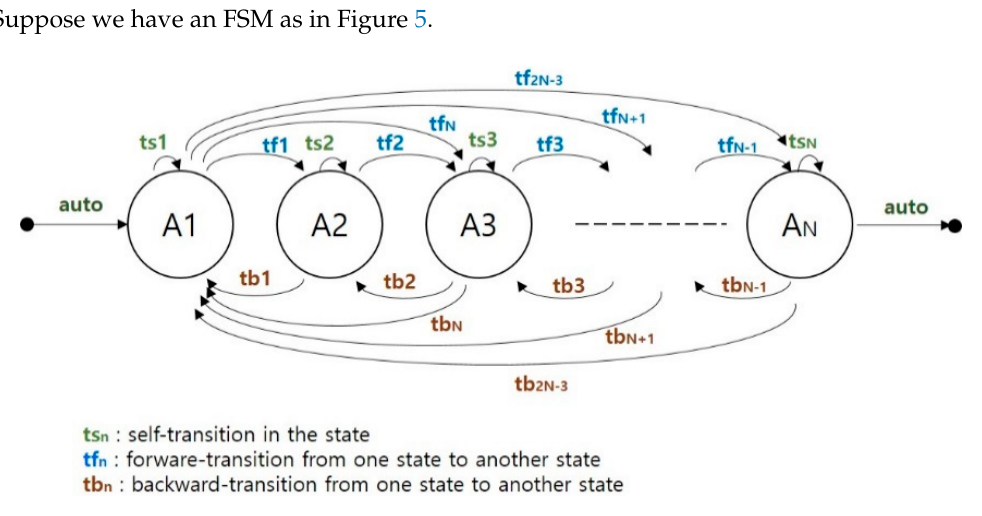
Figure 5. Sample FSM for testing time analysis.